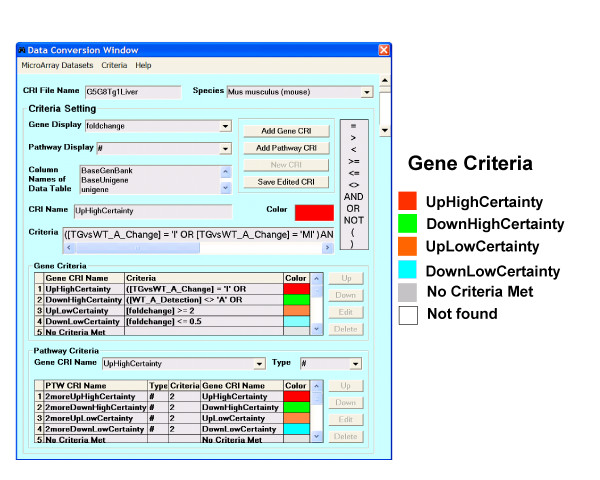
Example of a CRI file created for analysis of microarray data from the G5G8Tg mice, shown in the Data Conversion Window. The pathway level criteria (PTW CRI Name) are based on the criteria selected at gene level (Gene CRI Name).